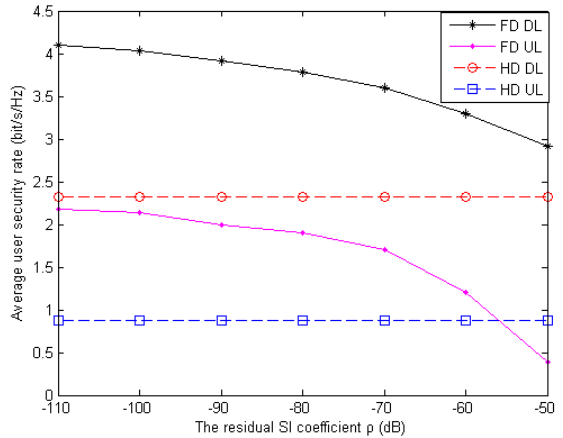
Figure 6. Average user security rate versus the self-interference (SI) coefficient of the antennas for the downlink (DL) and uplink (UL) in different FD and HD schemes.